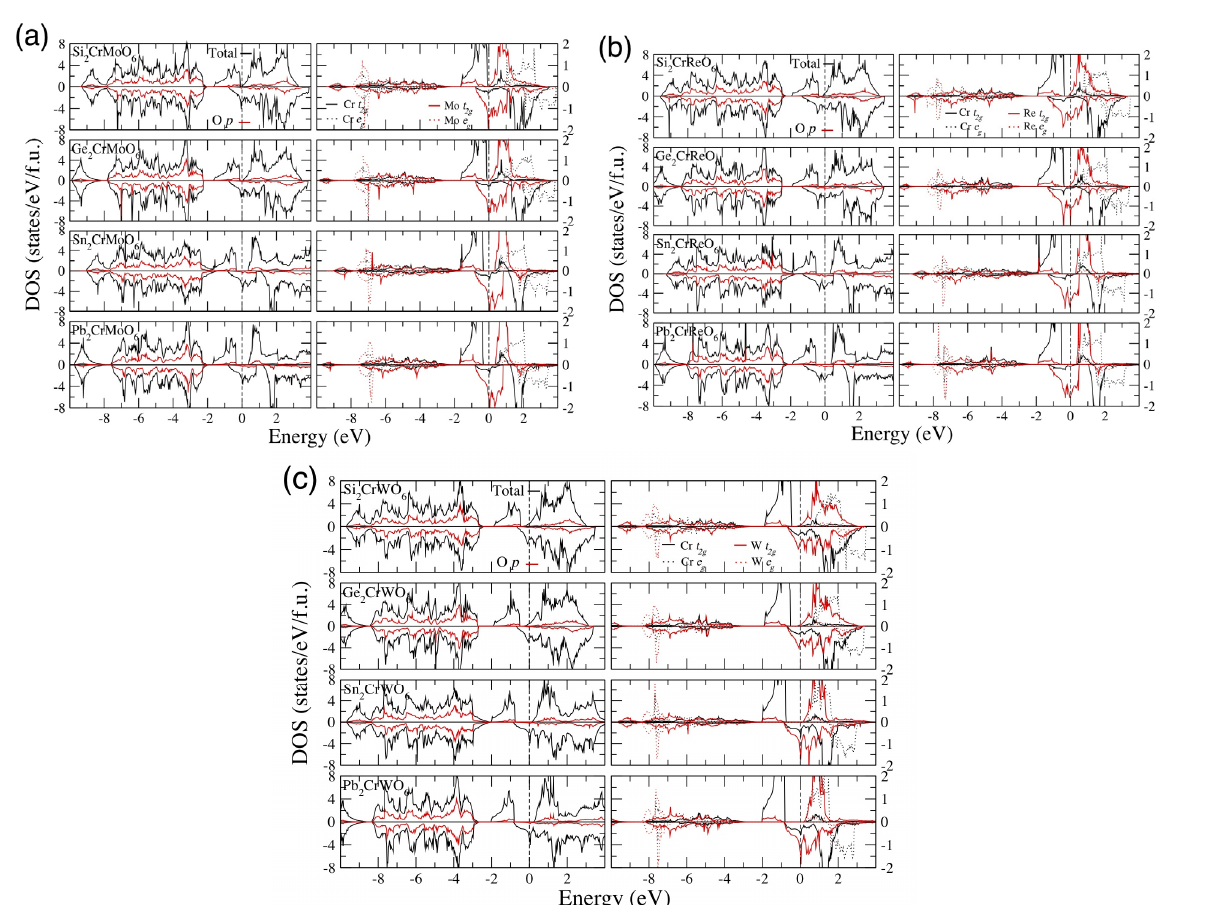
Figure 2. Calculated total, spin and site partial density of states in GGA of ( a ) A CrReO ; and ( c ) A CrWO . DOS, density of ( b ) A 2 6 2 6